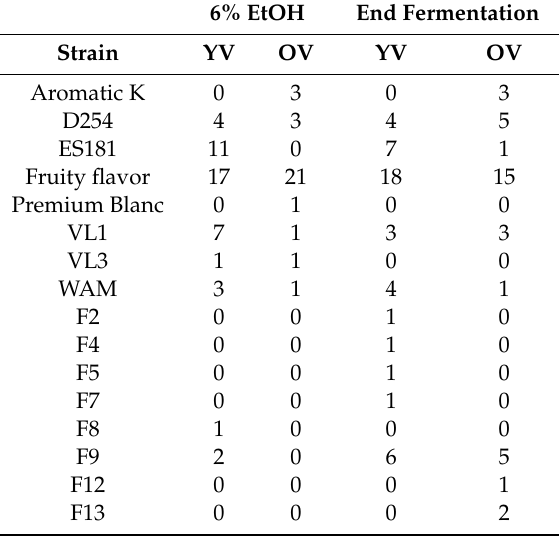
Table 2. S. cerevisiae strains isolated at 6% ethanol and at the end of fermentation during spontaneous fermentations of grapes harvested at